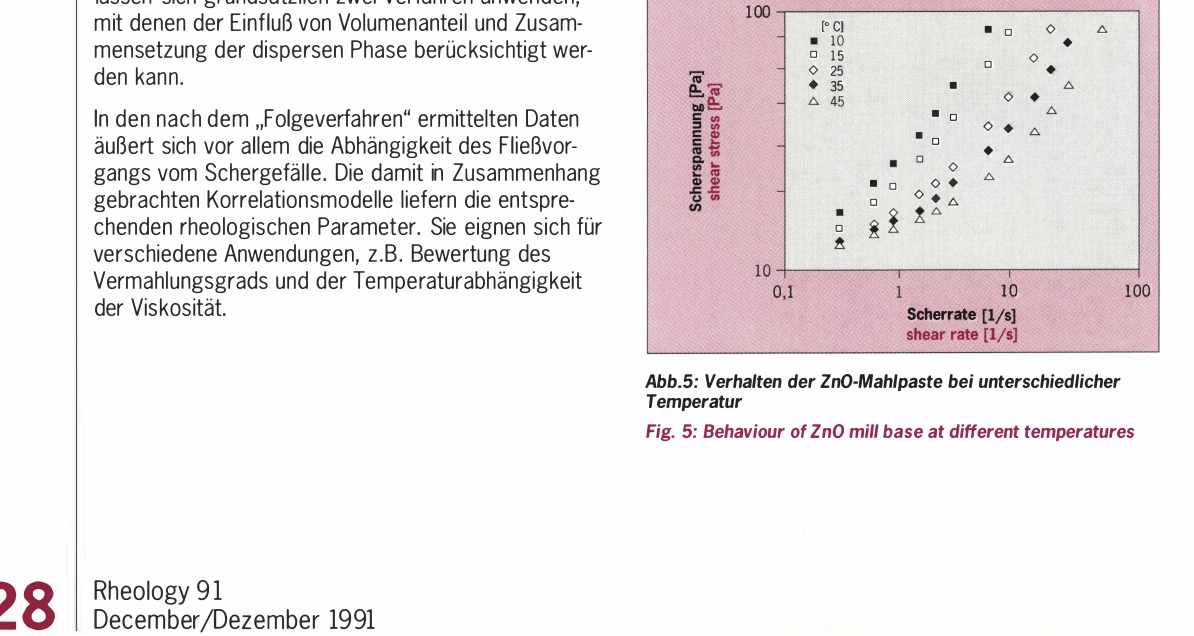
Fig. 5: Behaviour of ZnO mill base at different